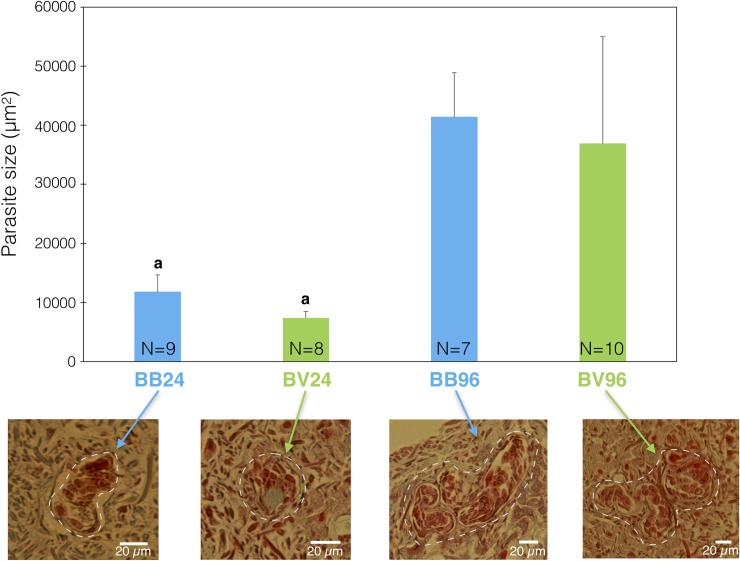
Development of parasites into snail tissues.A histological approach was used to monitor parasite size along the course of snail infection. The sympatric interaction (BgBRE x SmBRE) is shown in blue, and the allopatric interaction (BgBRE x SmVEN) is shown in green. For each experimental interaction, the parasite sizes were quantified at 24 and 96 h after infection. Morpho-anatomical aspects of the parasite are depicted to highlight a potential difference in parasite survival. N = 7 to 10sporocystes were used as indicated in the figure.Between-group parasite size differences were assessed using the Mann-Whitney U-test, with significance accepted at p<0.05 (indicated by “a” on the histograms).